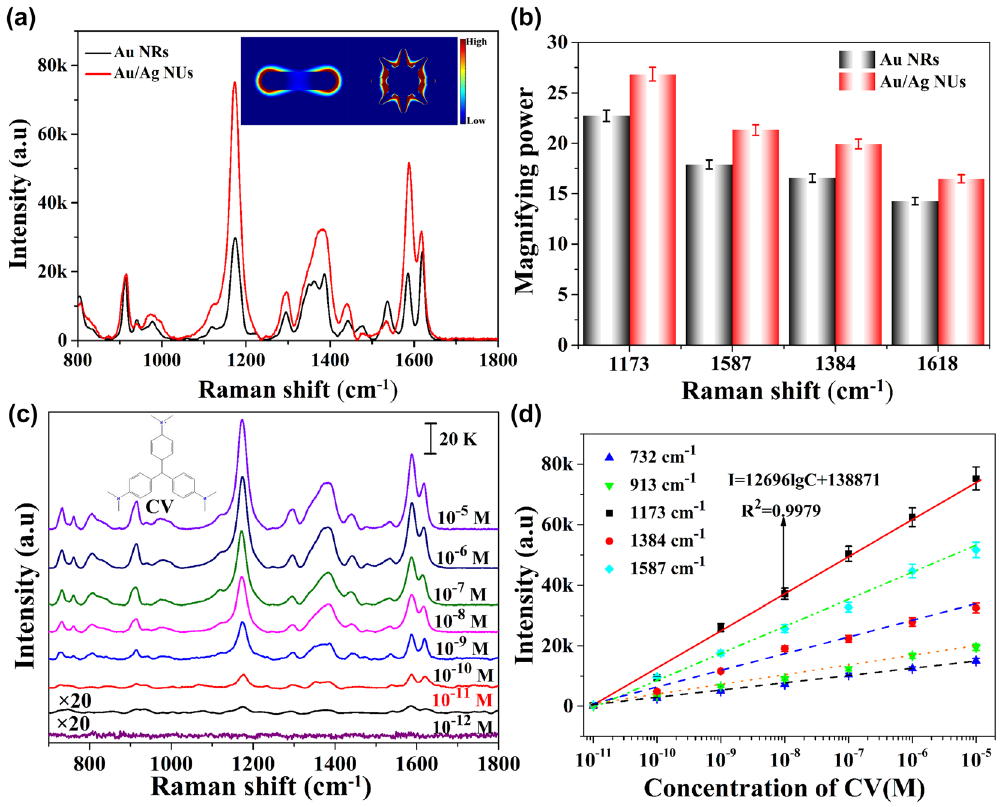
Figure 5: SERS tests of CV molecules in the double laser-induced system. (a) Raman signals of CV (10 − 5 M) in Au/Ag NUs and Au NRs solutions, respectively (Inset shows the FDTD calculations of relative electric fi eld intensitiesforindividualAuNRandAu/AgNUunder808nm).(b)TheenhancedamplitudesofduallasersystemsunderAu/AgNUsandAuNRs substrates(eacherrorbarindicatesthestandarddeviationof10differentspots).(c)Ramanspectraof10 − 5 – 10 − 12 MCVviadoublelaser-excited liquid-NIR-SERS. (d) The variations of doublelaser-triggeredRaman intensities at 732, 913, 1173, 1384 and 1587 cm − 1 versus the CV molecules concentrations in the range of 10 − 5 – 10 − 11 M (each error bar indicates the standard deviation of 10 different